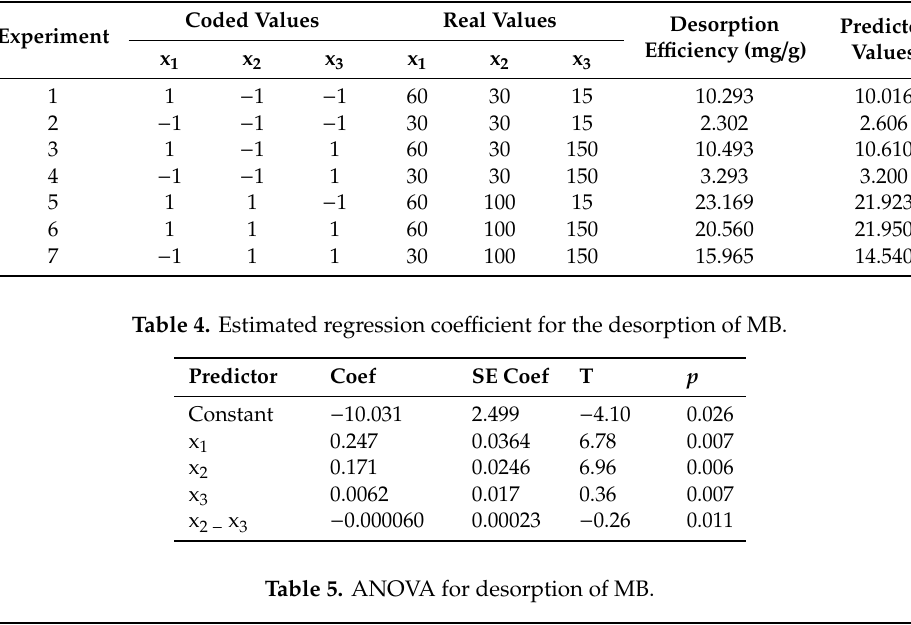
Table 3. Experimental and predicted results from the polynomial regression analysis.